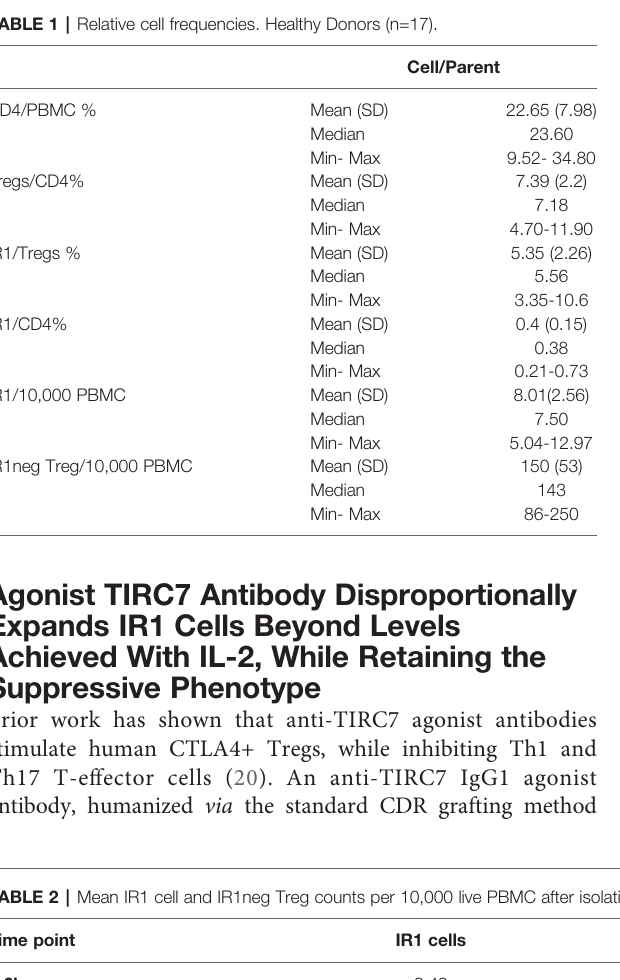
TABLE 2 | Mean IR1 cell and IR1neg Treg counts per 10,000 live PBMC after isolation (t=0h) and after activation with IL-2 (t=72h). N=8 subjects. Time point